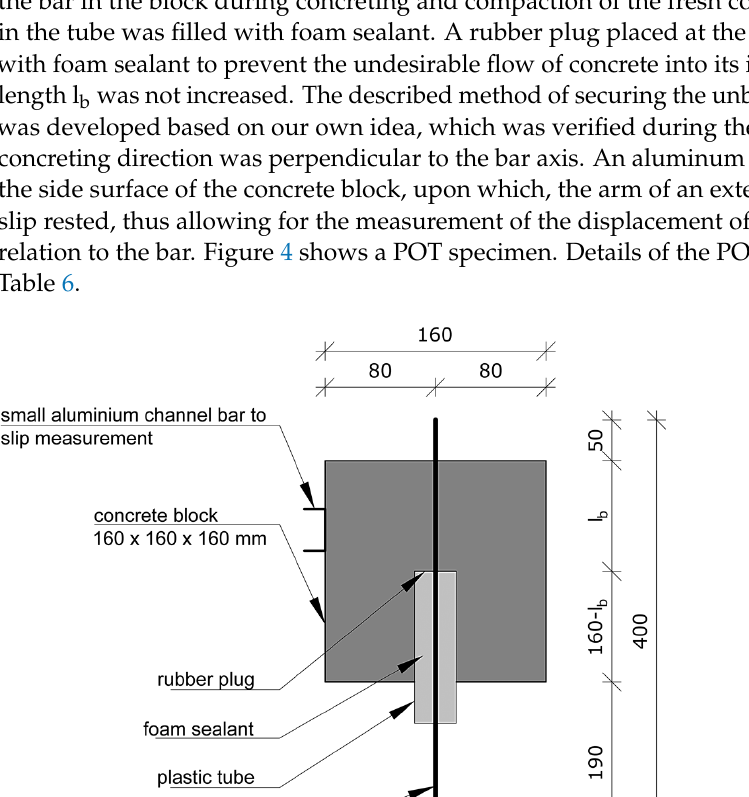
Table 5. Test results of selected strength parameters of reinforcing steel.